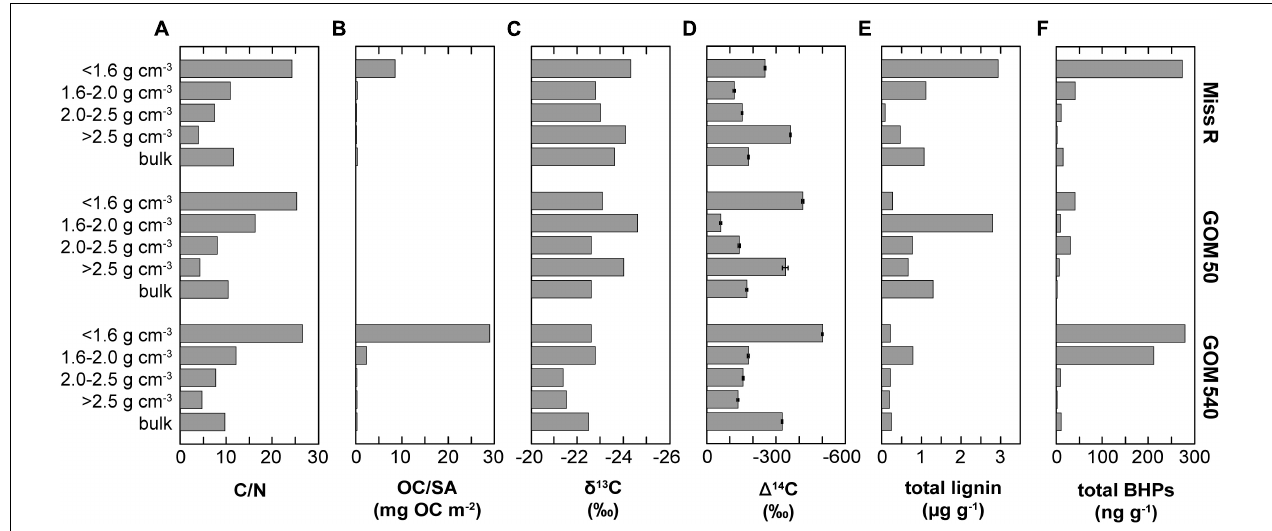
FIGURE 7 | Relationship between sedimentary parameters and BHP abundances in density fractions and bulk sediment samples along the Miss R – GOM transect. (A) C/N ratios, (B) surface area-normalized organic carbon loadings (OC/SA), (C) δ 13 C of OC, (D) (cid:49) 14 C of OC, (E) total lignin phenol concentrations, and (F) mass-normalized absolute BHP abundances. Data displayed in panels (A) through (E) were previously published by Wakeham et al. (2009).